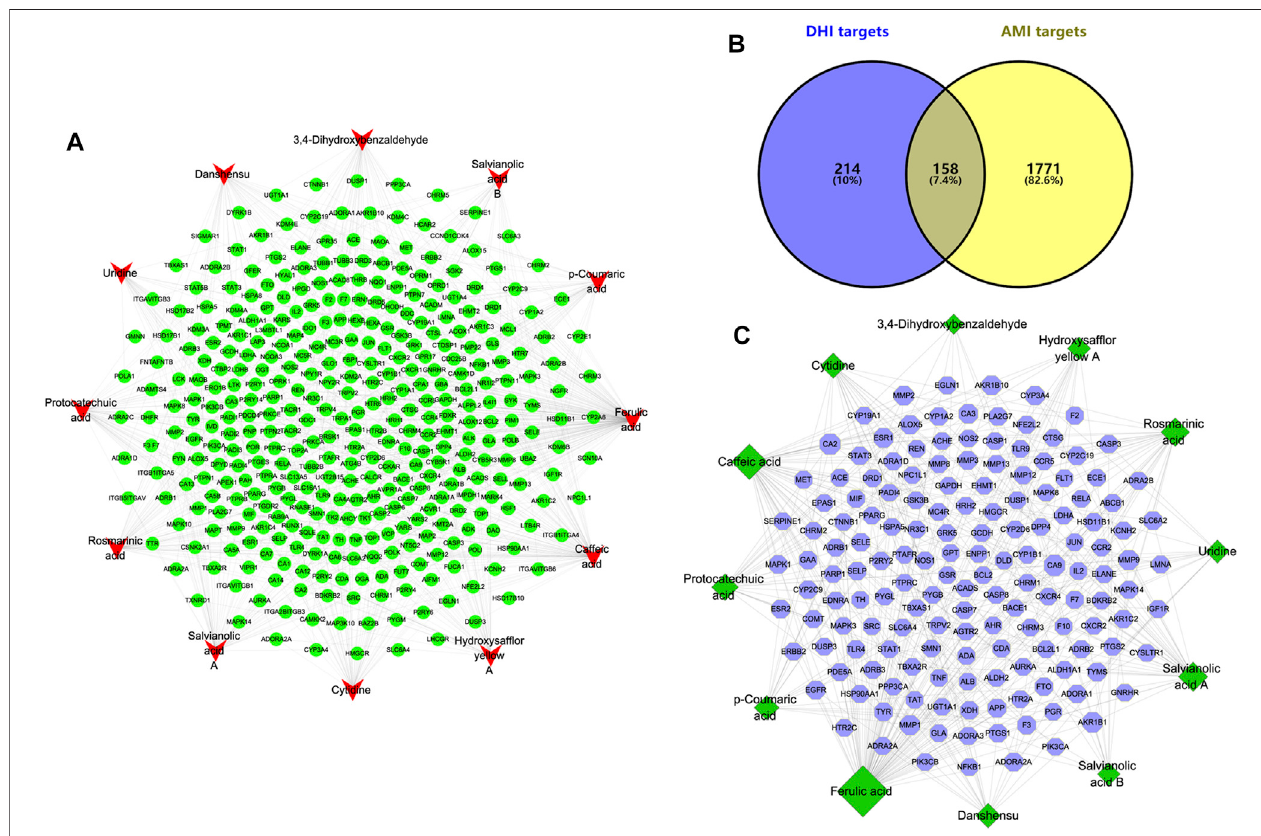
FIGURE3| Compound-target networkofDHIandCompound-AMItargetnetwork. (A) Compound-targetnetworkofDHI.Theredrepresentsthemaincompound of DHI, and the green represents the corresponding target ofthe compound. (B) Venn diagram of DHI targets and AMI targets. (C) Compound-AMItargetnetwork. The green represents the main compound of DHI, and the blue represents the common target of compound and AMI.